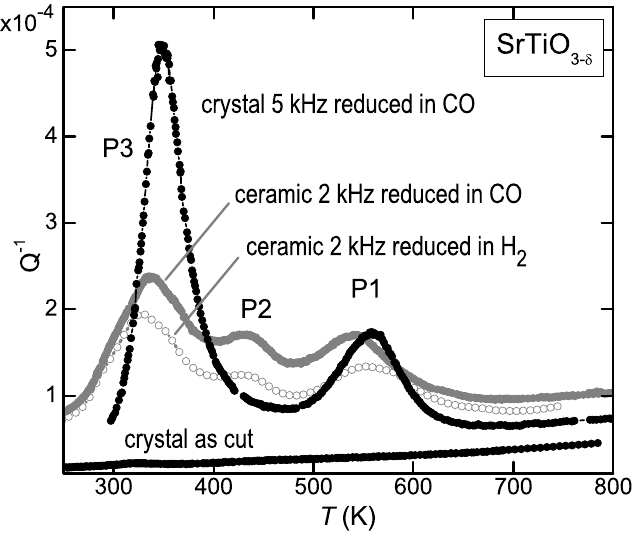
Figure 2. Elastic energy loss, Q − 1 , of ceramic and single crystal SrTiO 3 − δ in the virgin state and after reduction in CO or H 2 atmosphere.